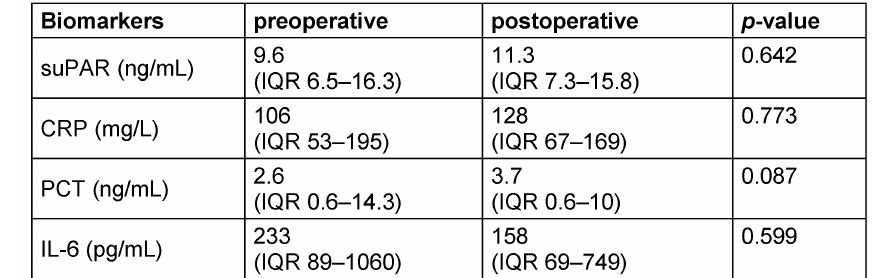
Table 3: Pre- and postoperative levels of biomarkers. Results of the tested parameters suPAR, CRP, PCT, and IL-6 levels